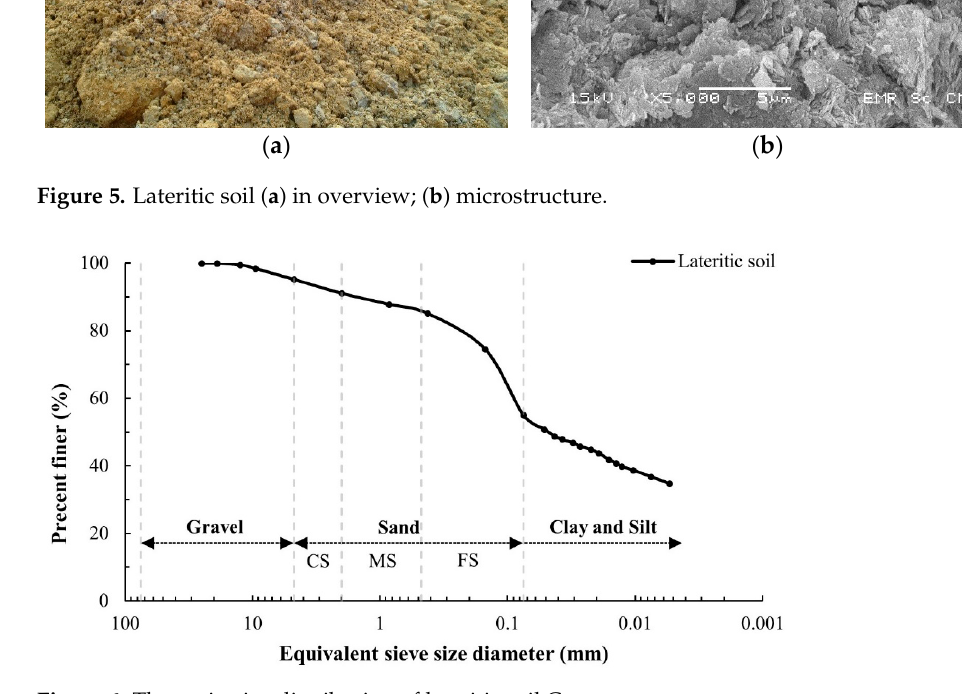
Figure 6. The grain size distribution of lateritic soil C.